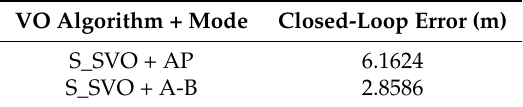
Figure 15. The visualization of the path for the robot walking on dataset2. The third coordinate (‘score’) displays the SIGD value of each frame in the path. ( a ) Path in two dimension; ( b ) Path with SIGD. Table 6. Experiment 2: The closed-loop error on dataset1.